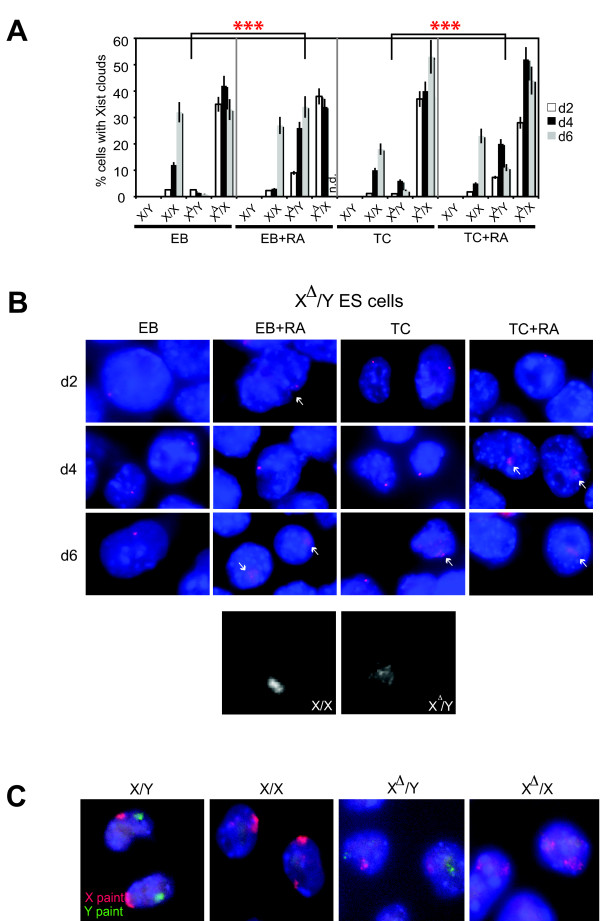
Ectopic Xist RNA clouds observed in Tsix-mutant male ES cells. A. Percentage of cells containing Xist RNA clouds. Note the high percentage of Xist-positive cells in XΔ/Y cells when differentiated in the presence of RA. Days of differentiation are listed as day 2 (d2), day 4 (d4), and day 6 (d6). Day 6 XΔ/X EB+RA, not determined (n.d.). X/Y, wild-type male ES line; X/X, wild-type female ES line; XΔ/Y, TsixΔCpG/Y male ES line; XΔ/X, TsixΔCpG/+ female ES line; n > 200 for each timepoint and cell line examined. Error bars represent the standard deviation from three independent biological replicates. P was calculated by paired, two-tailed Student's t-tests. Differences in the number of Xist+ cells for RA-free versus RA-induced XΔ/Y cells were statistically significant on all differentiation days (each red asterisk denotes P < 0.05 for day 2, day 4, and day 6 comparisons). EB, EB+RA, TC, and TC+RA conditions are described in the Materials and Methods. B. Xist RNA FISH showing ectopic and diffuse Xist cluster formation (arrows) in differentiating TsixΔCpG male cells. Arrows denote Xist RNA clusters. The RNA FISH probe is double-stranded. Pinpoint signals primarily detect mildly elevated Xist expression in mutant cells caused by the Tsix deficiency, though ~10% residual Tsix expression from an upstream promoter may also contribute [13]. Below is a side-by-side comparison at day 6 (in grayscale) of a normal compact Xist RNA cloud (X/X, left) next to the ectopic dispersed Xist cluster observed in XΔ/Y cells (right). C. X- and Y-chromosome paint confirm that all ES cell lines carry the appropriate number of sex chromosomes. Red, X-chromosome; green, Y-chromosome.